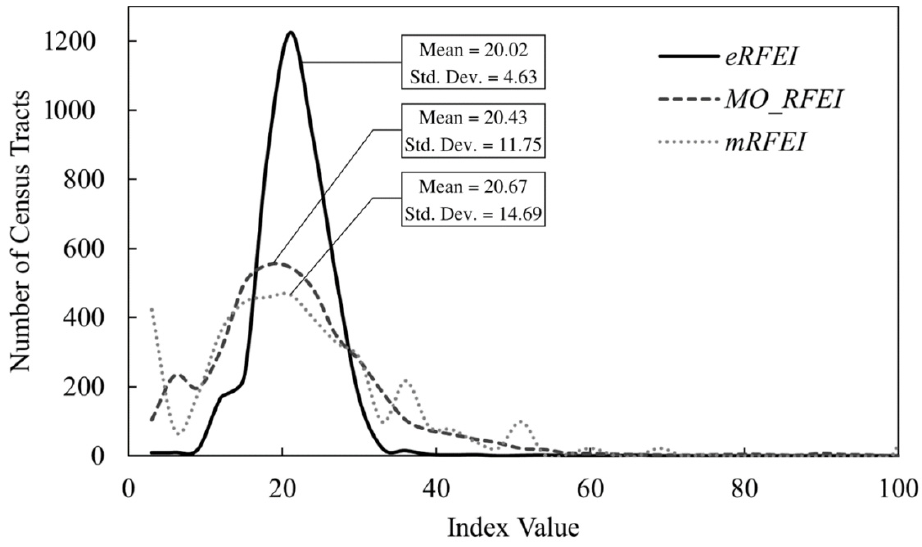
Figure 4. Frequency distributions of the three food environment indices with their means and stand- ard deviation.